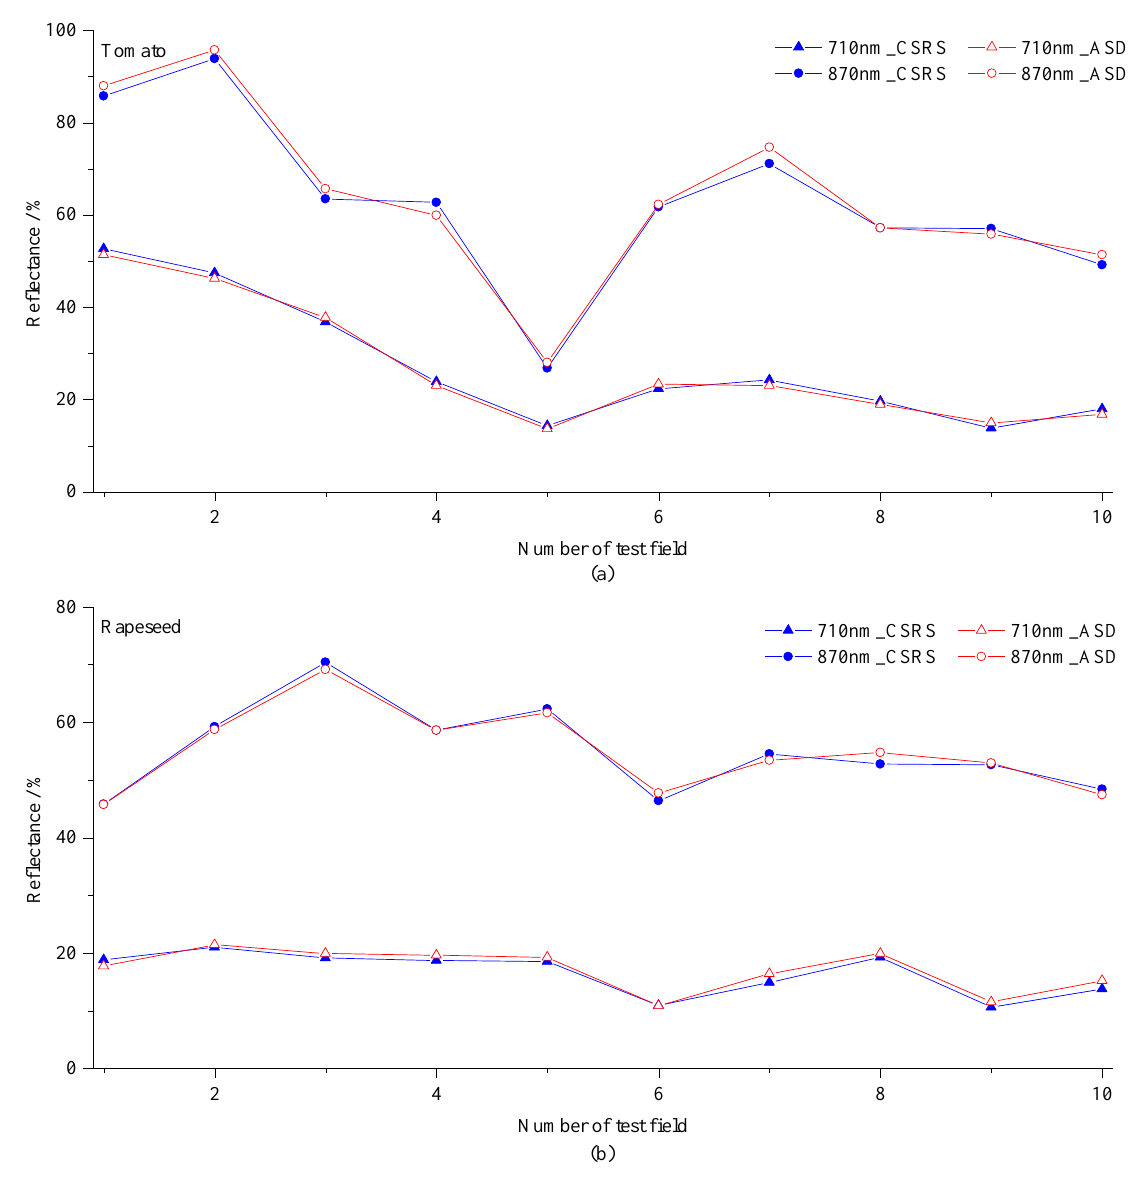
Figure 16. Crop canopy reflectance measured by the CSRS and ASD spectrometer. ( a ) Tomato; ( b ) Rapeseed.